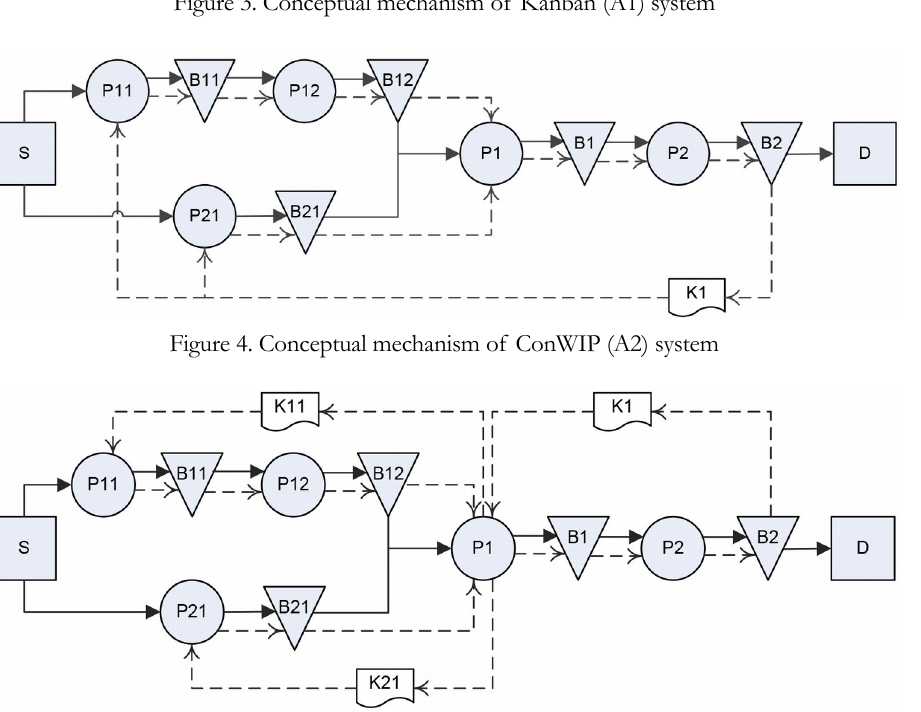
Figure 5. Conceptual mechanism of hybrid1 (A3) system